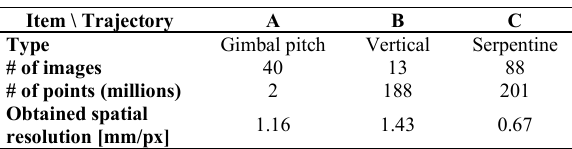
Table 2. Trajectories simulation results.